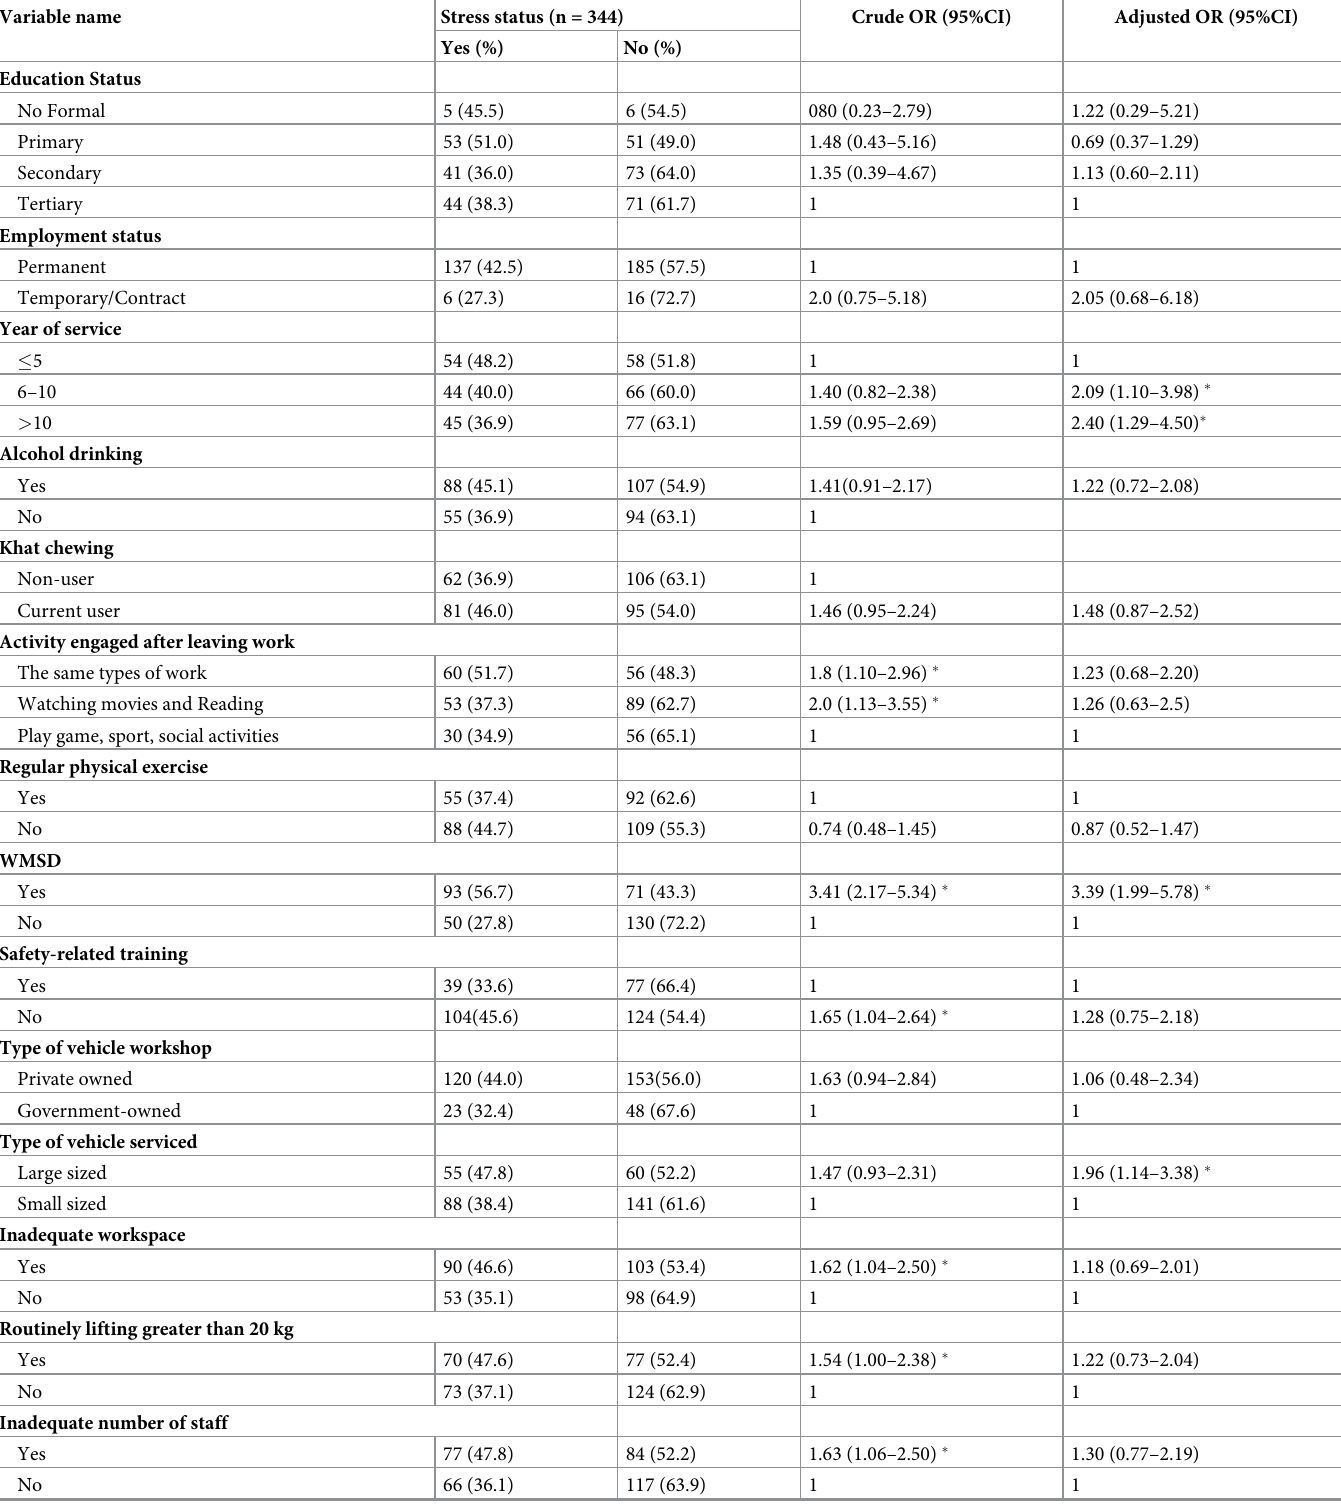
Table 3. Multivariate logistic regression of factors associated with work-related stress among vehicle repair workers in Hawassa city, Ethiopia, May